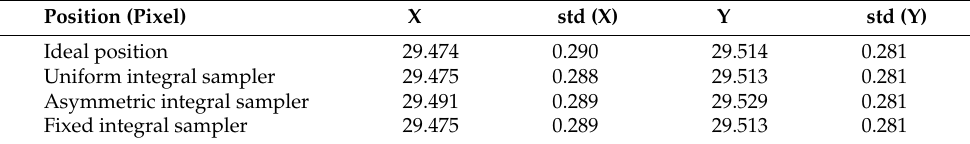
Table 3. Results of mean position measurement by uniform, asymmetric, and fixed integral